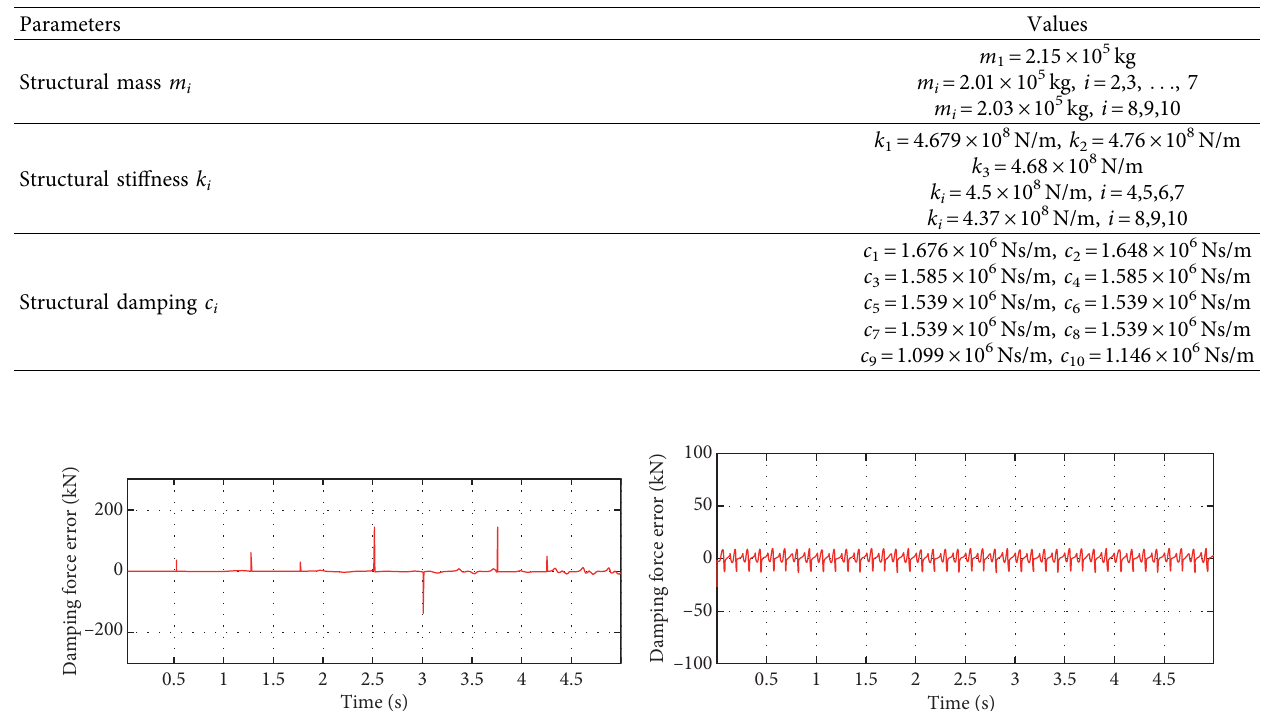
Figure 8: Predicted and target voltages (damping forces) for validation dataset III. Table 1: Structural parameters of the building [40].